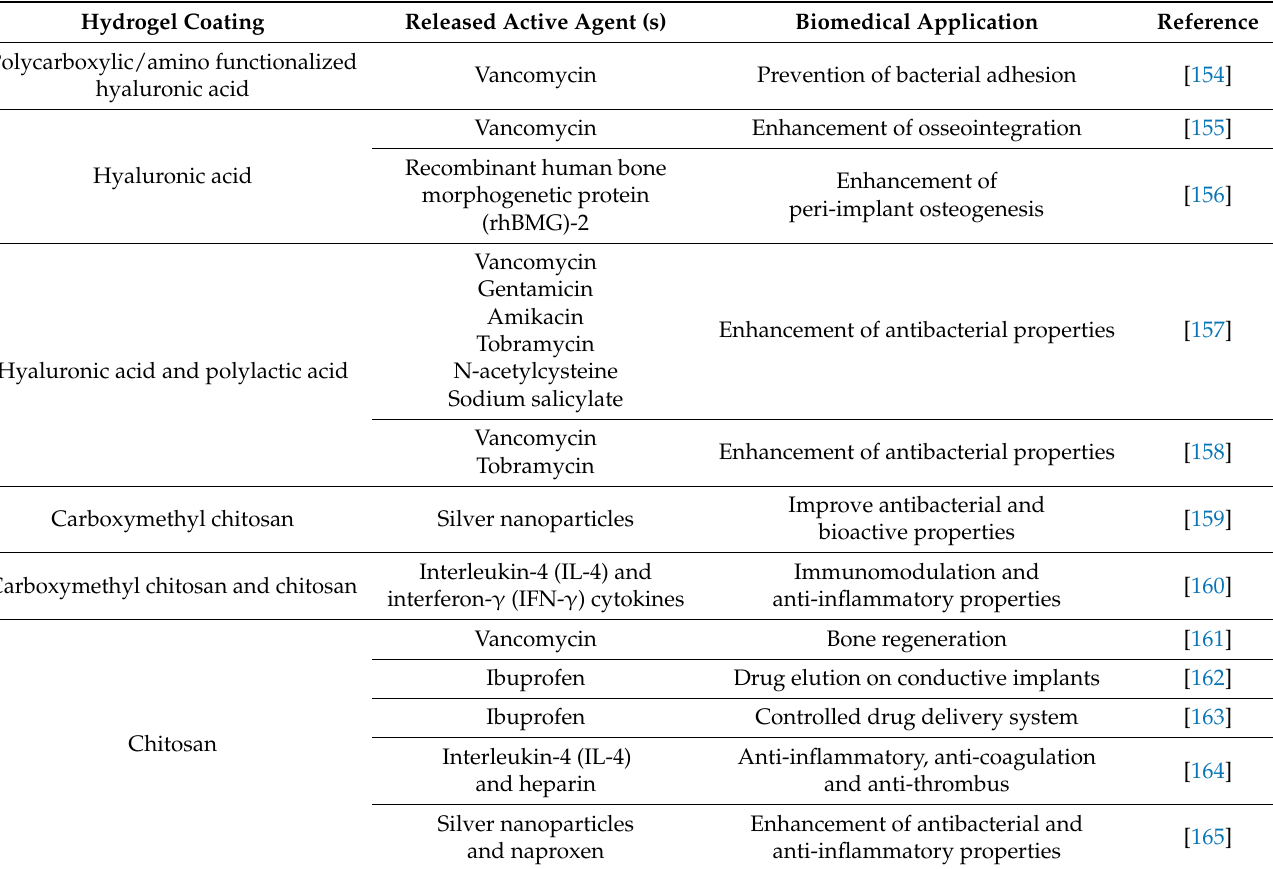
Table 1. Hydrogel coatings for active agents release in biomedical area to create Ti active surfaces. Hydrogel